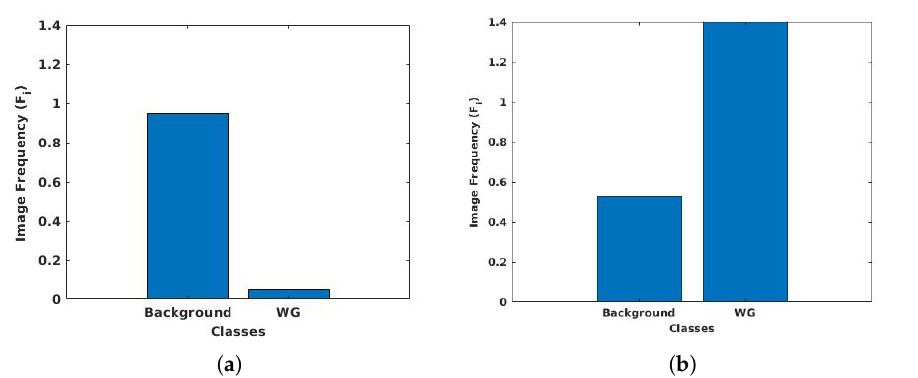
Figure 5. Pixel distribution of ( a ) original images and ( b ) after class weighting for the UKMMC